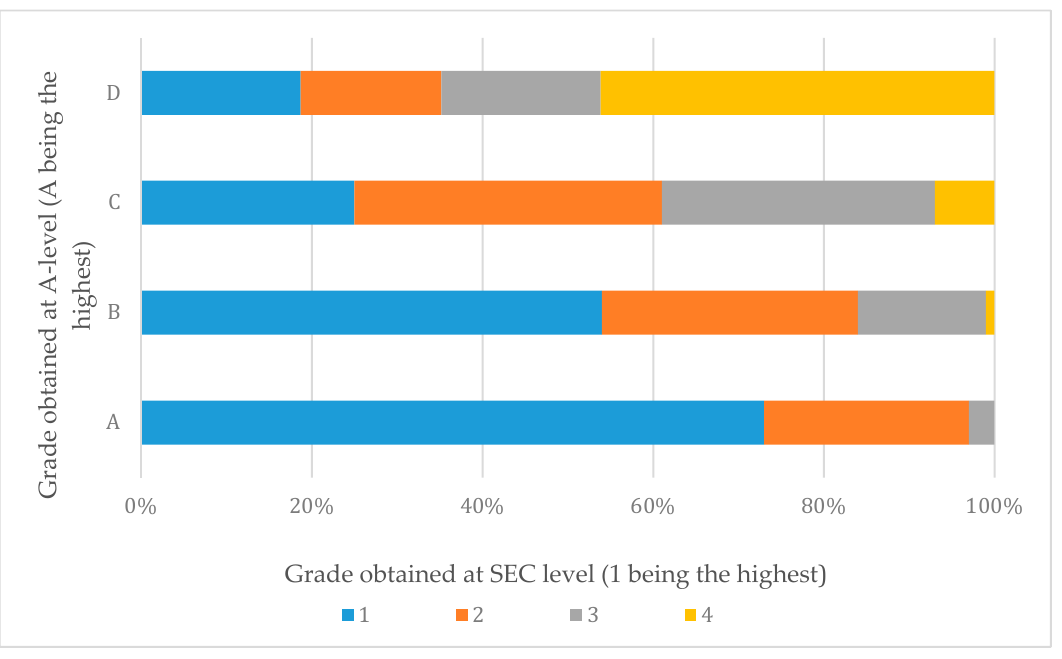
Figure 1. The grades obtained at Secondary Education Certificate (SEC) level and the corresponding grade at Advanced Matriculation (AM) level .